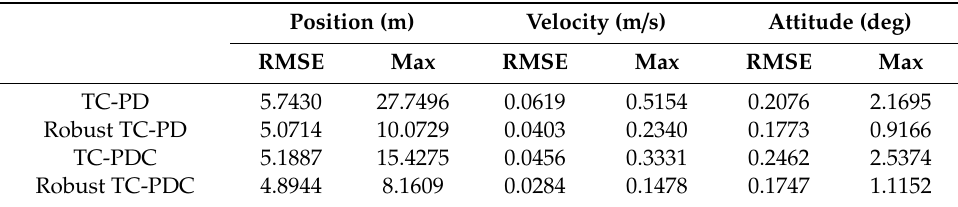
Figure 14. Performance of the proposed method in challenging environments. ( a ) TC-PD and robust TC-PD; ( b ) TC-PDC and robust TC-PDC. Table 8. RMSE and maximum errors in GNSS challenging environments.